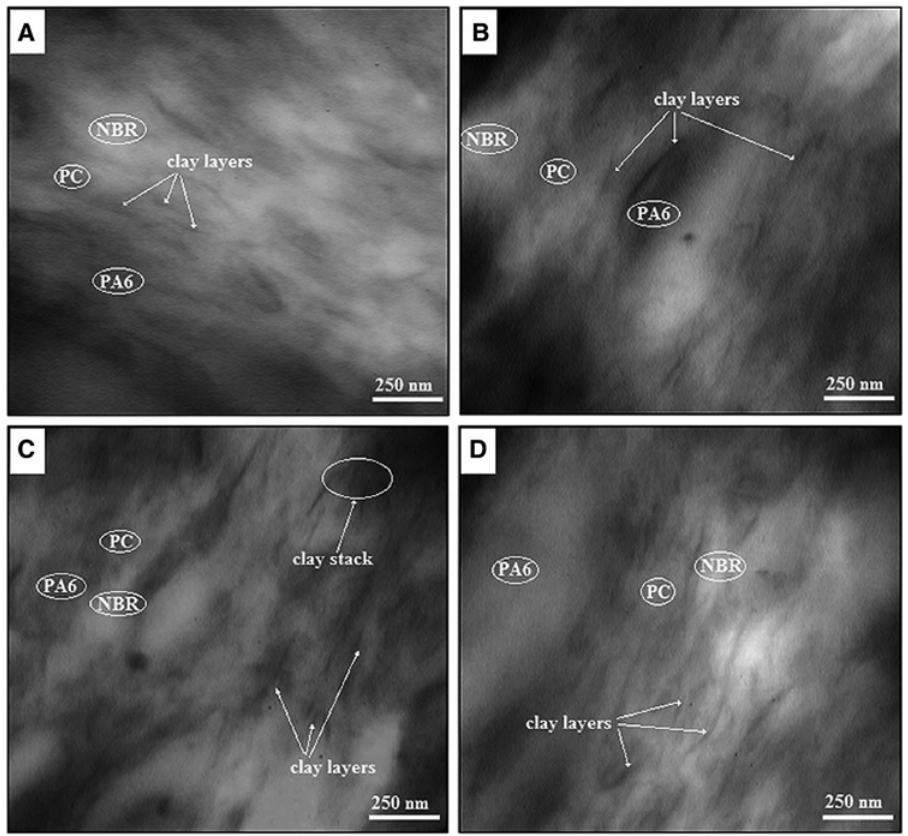
Figure 5: TEM images of (A) PN3, (B) PN5, (C) PN7, and (D) PNG5 samples.